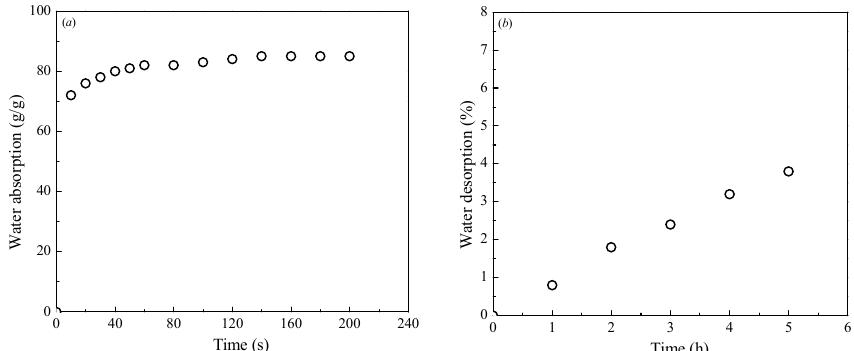
Figure 1. Time dependent water absorption and desorption behavior of the superabsorbent polymer (SAP) used: ( a ) water absorption, ( b ) water desorption.